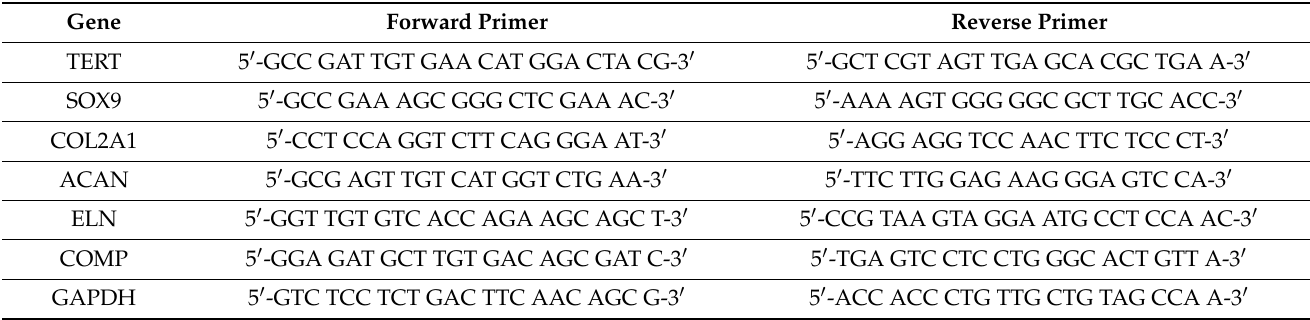
Table 3. List of